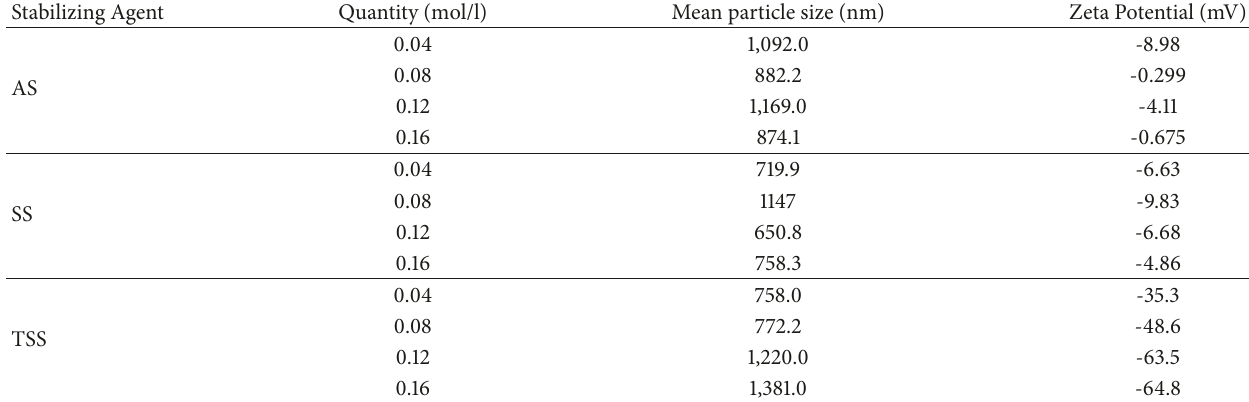
Table 2: Particle size and zeta potential test results of ZnB after attrition milling.